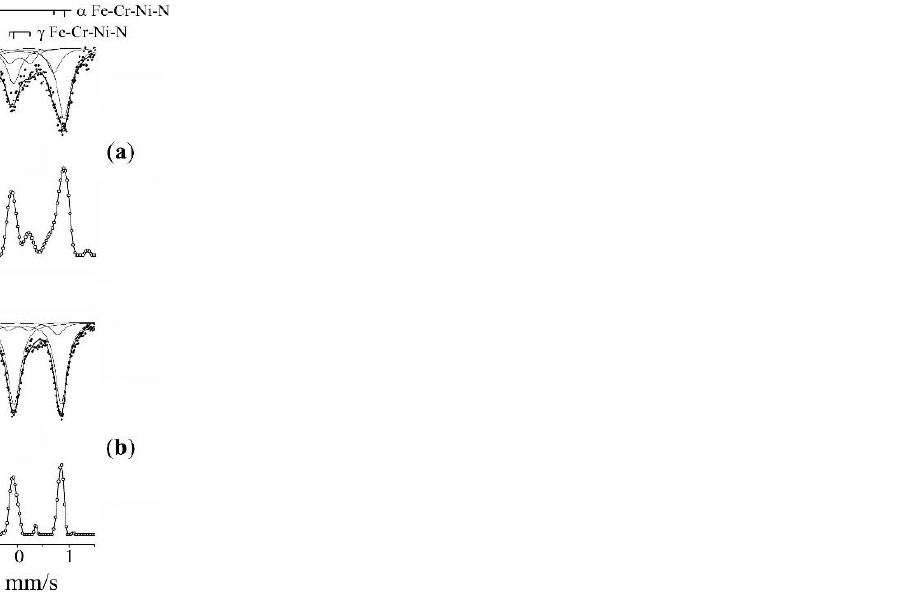
Figure 4. The central part of spectra for the mixture “C” (Fe–6Ni + CrN) and the distributions p ( V ). Treatment: ( a ) — PBM, 10 h; ( b ) — PBM, 10 h + anneal 650 °C, 1 h.